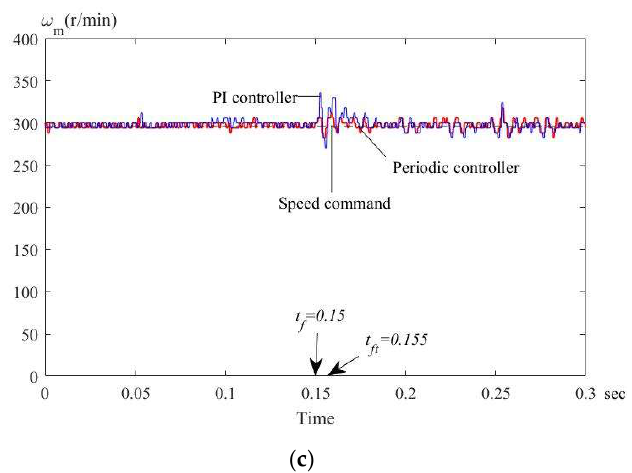
Figure 24. Measured three-phase currents of the fault-tolerant control when the a -phase current sensor was faulty: ( a ) current using PI controller; ( b ) current using periodic controller; ( c ) speed.